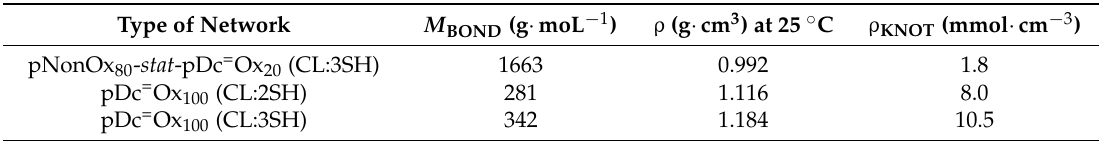
Table 2. Molecular weights per polymer analogously formed bond in the three (co)poly(2-oxazoline)-based networks investigated in this